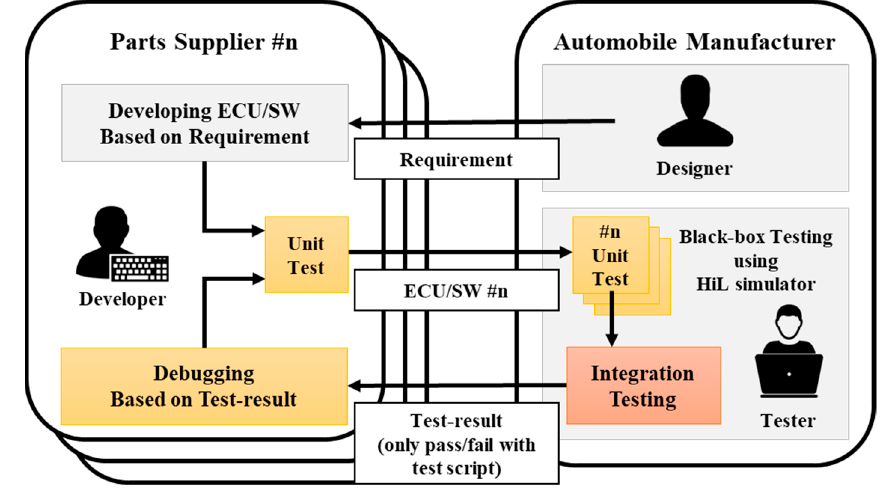
Figure 1. Development and testing processes of ECU/SW by OEM. ECU/SW: electronic control unit/automotive software; OEM: original equipment manufacturers; HiL: Hardware-in-the-Loop.